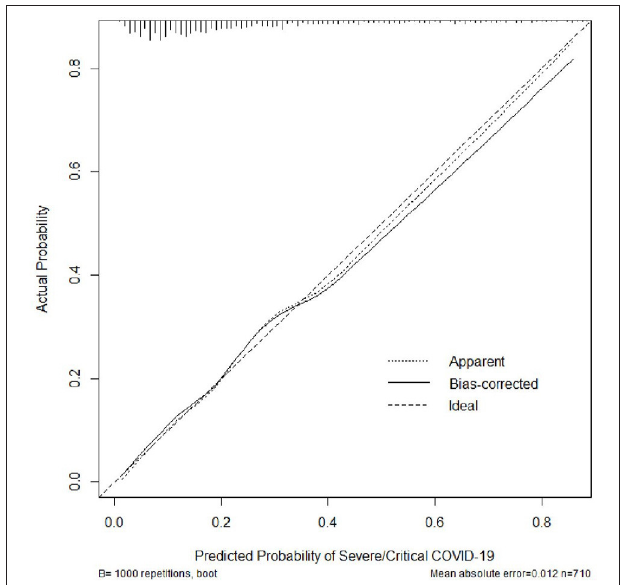
FIGURE 3 | Calibration plot for the nomogram. The bias-corrected (overfitting-corrected) estimates of predicted vs. observed values were obtained based on bootstrap resampling with 1,000 samples for internal validation